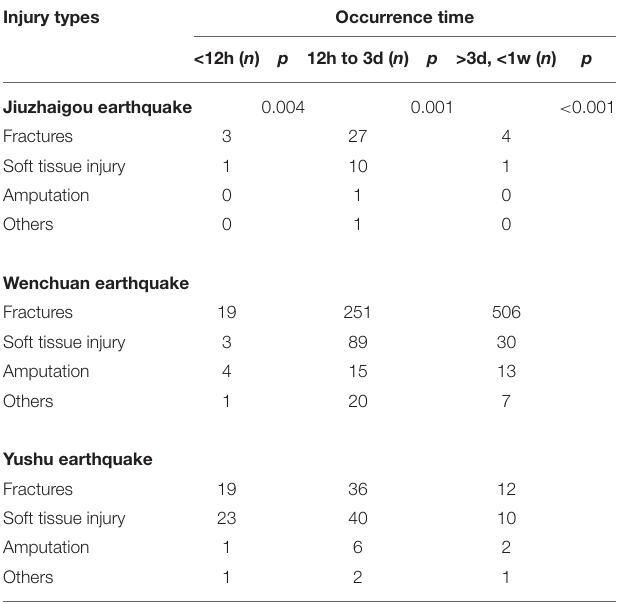
TABLE 4 | The time of the different injury types in Jiuzhaigou, Whenchuan and Yushu earthquake patients. Injury types